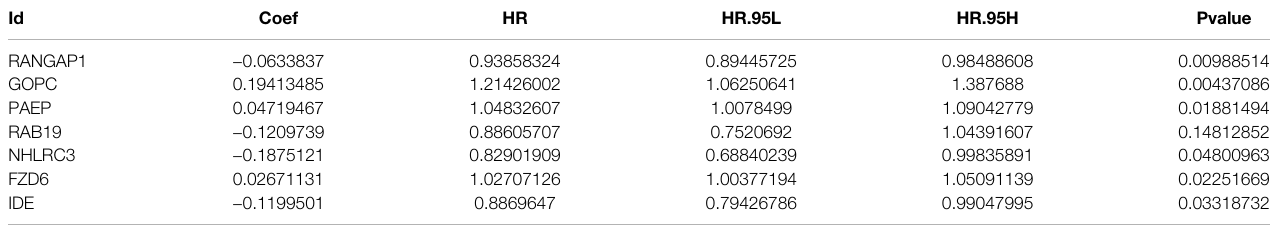
TABLE 2 | the result of Multivariate COX regression analysis.